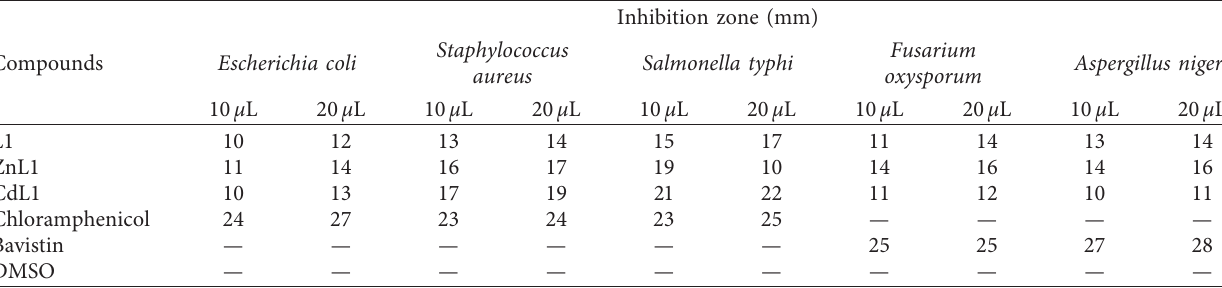
Figure 1: The synthetic scheme of Table 1: Bacterial and fungal growth inhibition zone (mm).